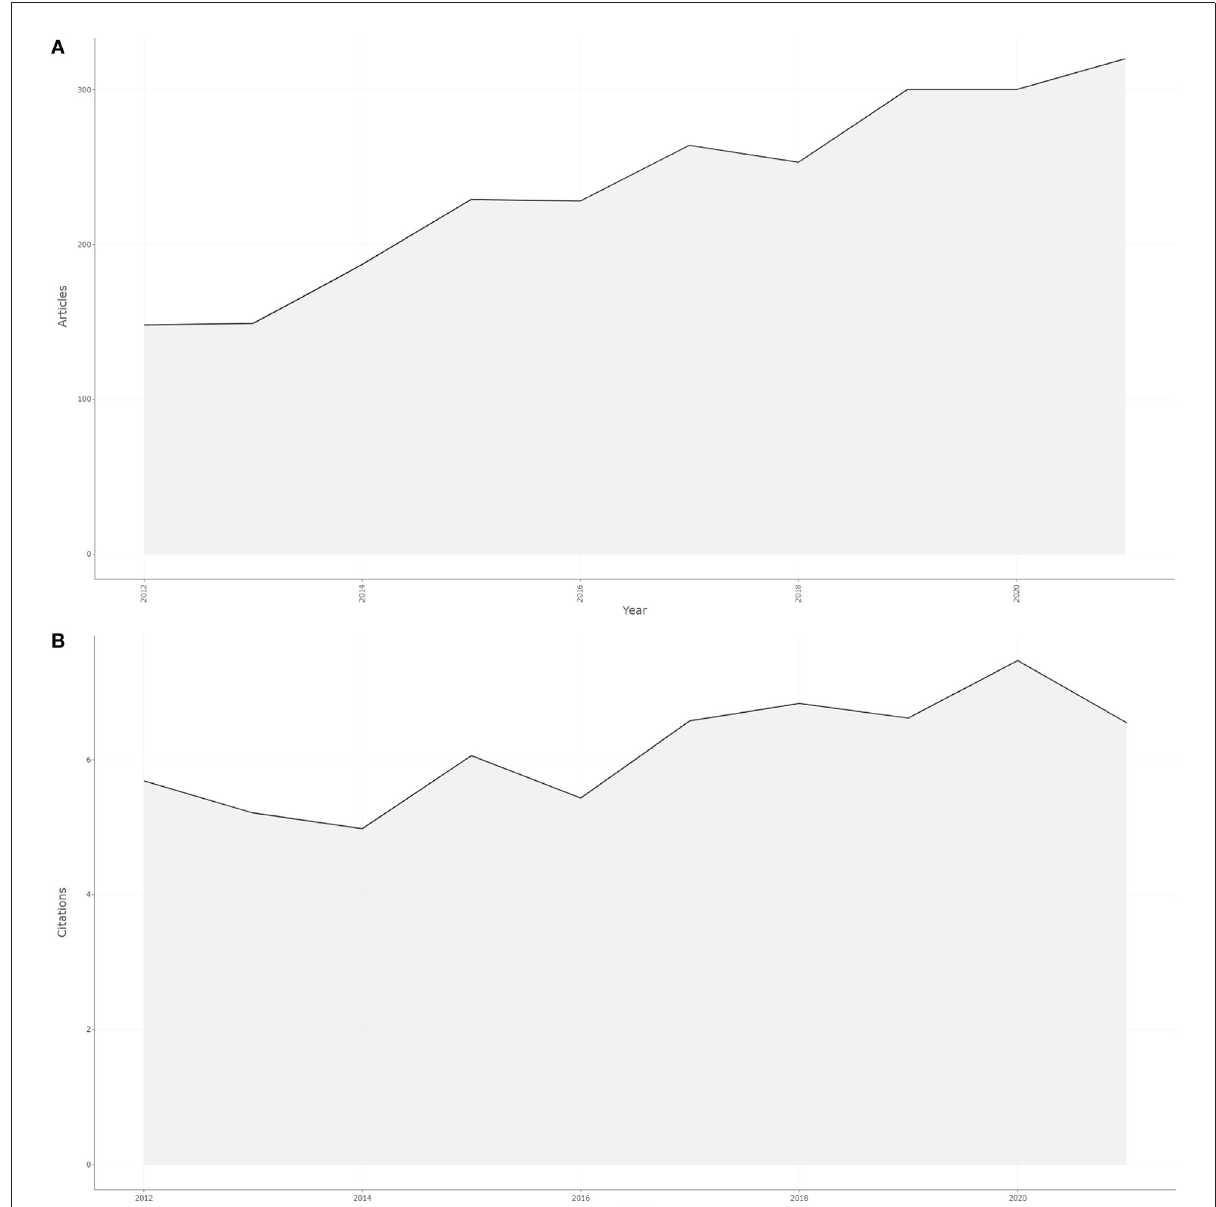
FIGURE2 The trend of the publications output and the average article citations on the research of emerging contaminants and cancer from 2012 to 2021. (A) The trend of the publications output on the research of emerging contaminants and cancer from 2012 to 2021. (B) The trend of the average article citations on the research of emerging contaminants and cancer from 2012 to 2021.